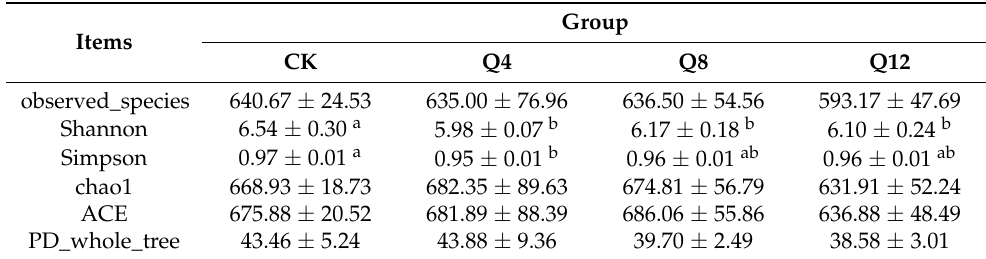
Figure 1. Analysis of cecal microbial diversity. Notes: ( A ) Operational taxonomic units − Venn (OTU − Venn) analysis; ( B ) Saturation curve of species number (dilution curve); ( C ) Species accumula- tion box pattern; ( D ) PCA analysis. Table 5. Alpha diversity